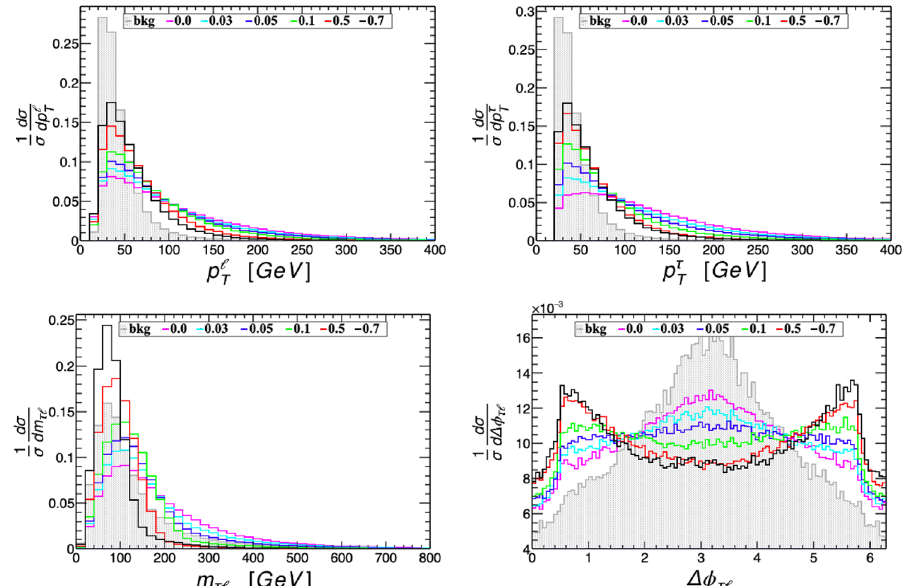
Figure 9 . Some significant distributions of the ‘ τ 2 ν 2 φ channel. As for the 3 τ ν 2 φ case, gradual shift of the peaks in the distributions can be attributed to the change in the mixing parameter. The distributions are labelled with the respective values of s α